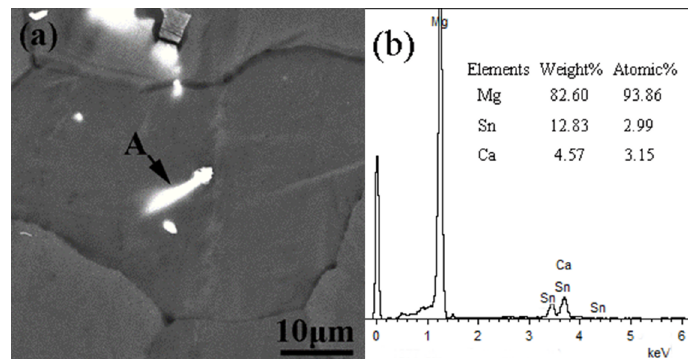
Figure 5. Backscattered electron image of the AZ31-0.75% alloy ( a ) and the EDS analysis of the bright particle A ( b